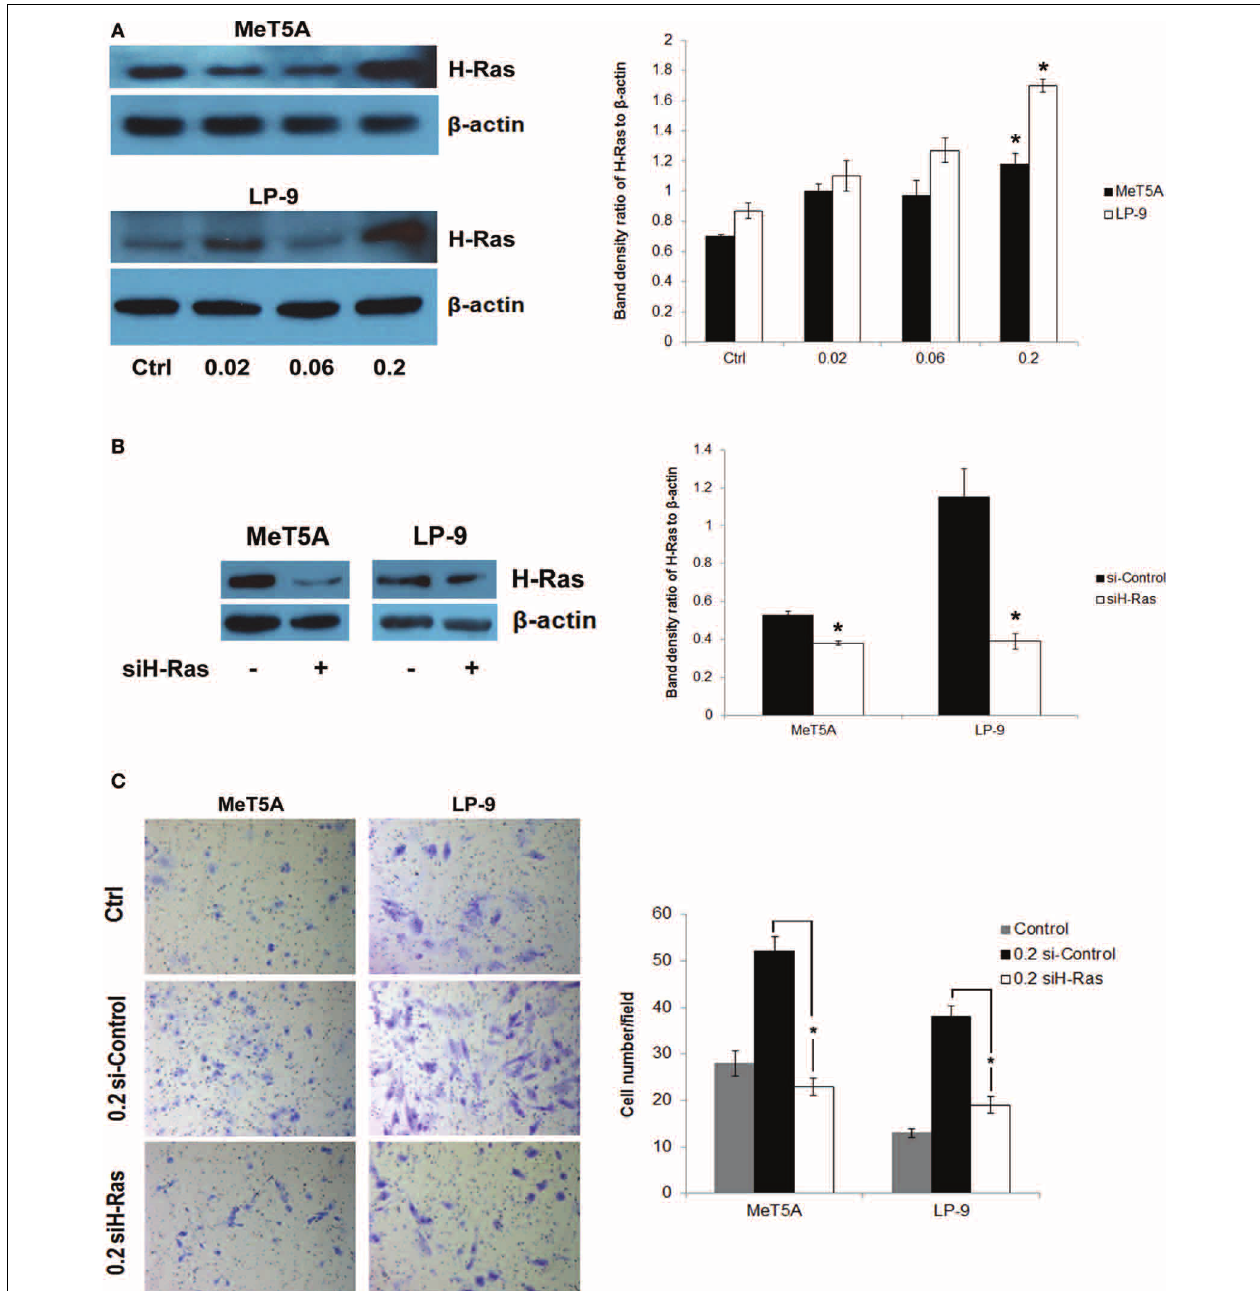
FIGURE 2 | Up-regulation of H-Ras in SWCNT-exposed mesothelial cells. Total H-Ras protein expression in SWCNT-exposed MeT-5A and LP-9 cells were analyzed by Western blotting. Band densities were determined and presented as a bar chart. Overexpression of H-Ras was observed in both SWCNT-exposed cell types at the high dose of 0.2 μ g/cm 2 (A) . SWCNT